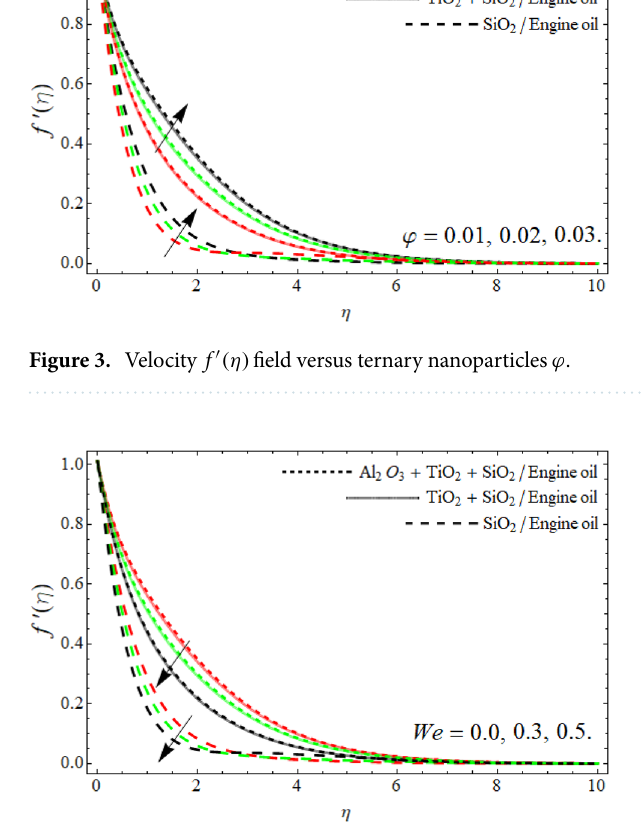
Figure 4. Velocity f ′ (η) field versus Weissenberg number We .